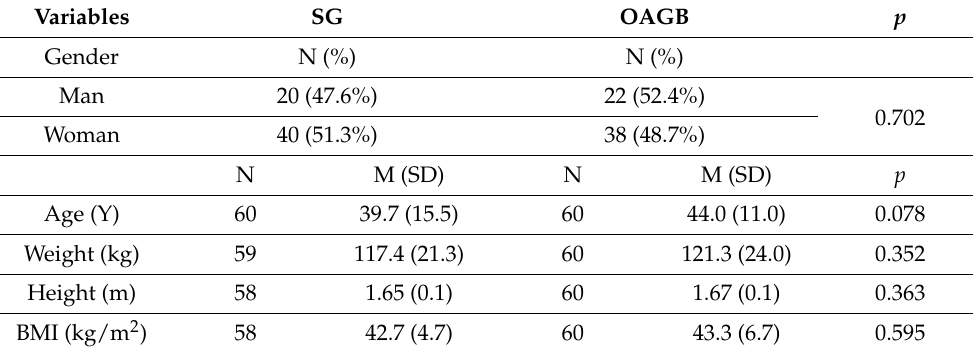
Table 2. Pre-operative study’s groups characteristics at